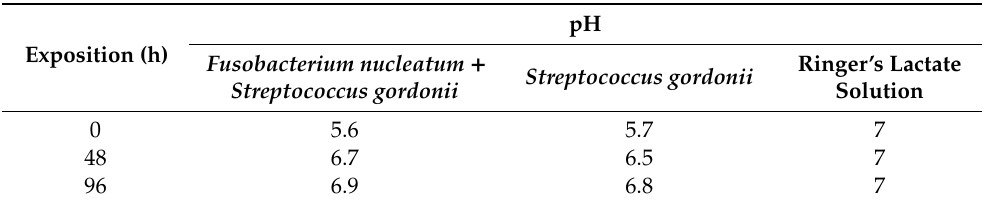
Table 1. pH measurements of